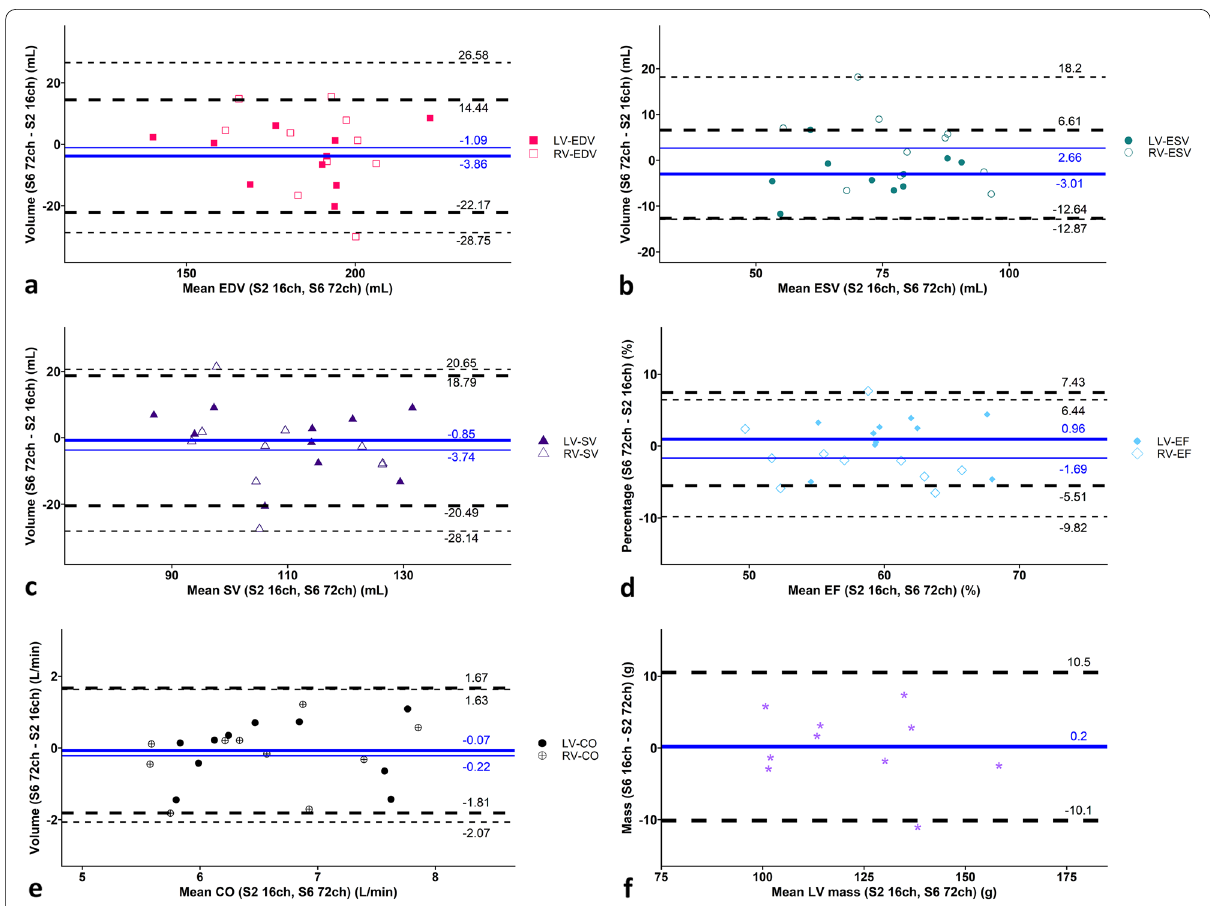
Fig. 6 Bland-Altman plots comparing ( a ) left ventricular (LV) and right ventricular (RV) end-systolic volumes (ESV), ( b ) LV and RV end-diastolic volumes (EDV), ( c ) LV and RV stroke volumes (SV), ( d ) LV and RV ejection fractions (EF), ( e ) LV and RV cardiac outputs (CO), and ( f ) LV mass measured with SENSE-2 16-channel receiver array (7 breath-holds) as reference compared to SENSE-6 72-channel receiver array (2 breath-holds). The solid blue line indicates the mean bias (thick LV, thin RV), with the dashed black lines showing the upper and lower limits of agreement, determined = = as mean bias 1.96 standard deviation, between the two techniques (thick dashed LV, thin dashed RV). Confidence intervals of the mean ± × = = difference in the Bland-Altman plots are presented in Table 5. ch Channel, CS Compressed sensitivity encoding, S Sensitivity